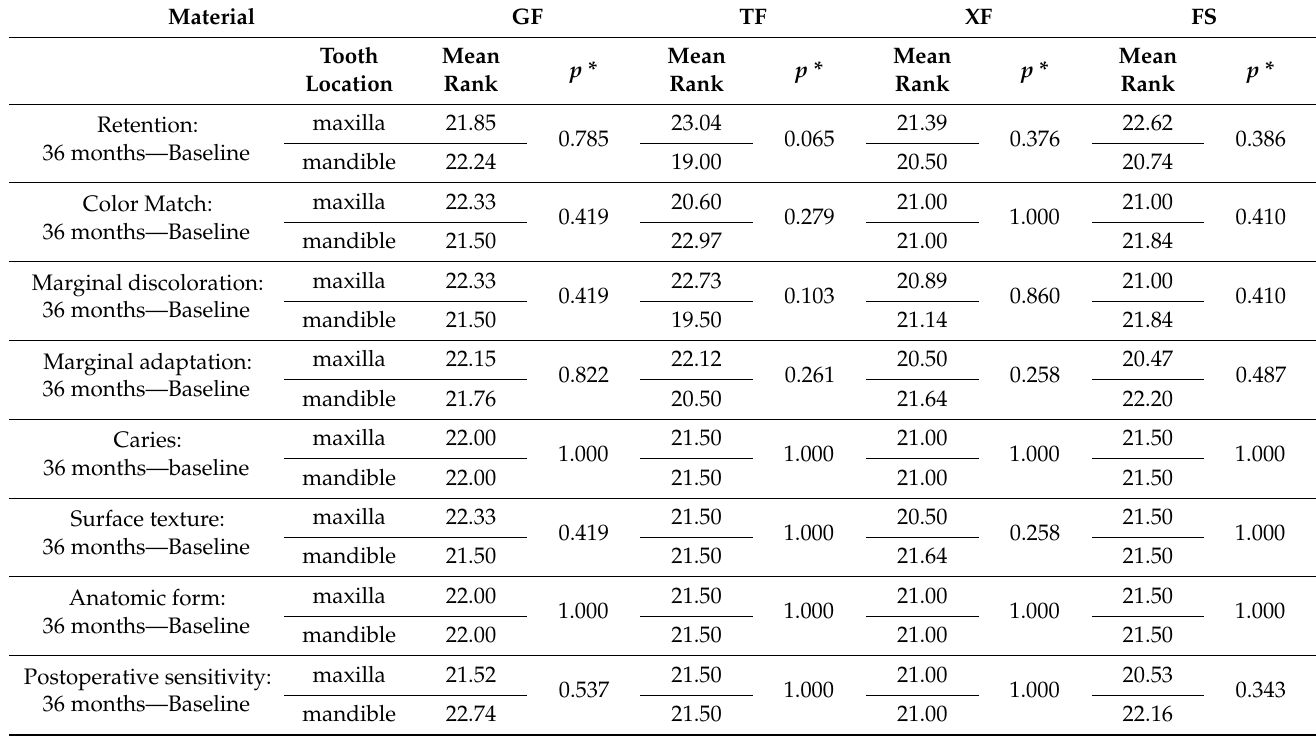
Table 5. Analysis of tested materials considering USPHS criteria and location in maxilla or mandibula jaw.